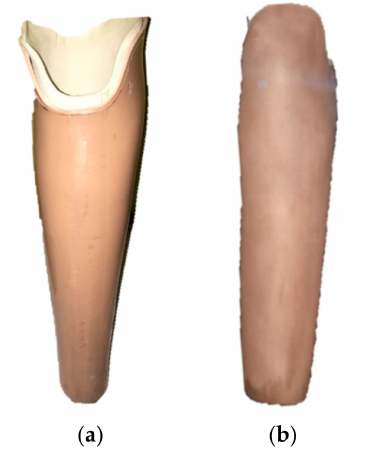
Figure 9. ( a ) Casting method and ( b ) photogrammetry-3D printing method